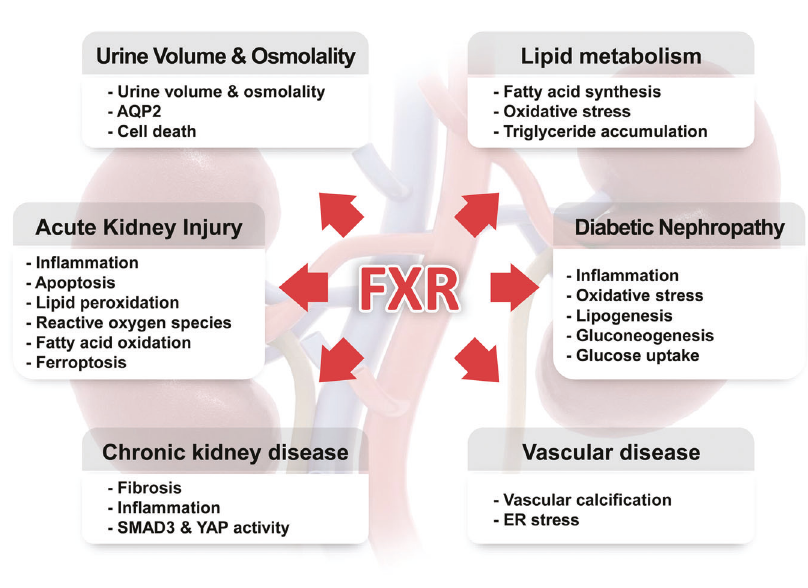
Fig. 1 Roles of FXR in the physiology and pathophysiology of the kidney. Schematic of the roles of FXR in kidney physiology and diseases. Activated FXR in the kidney regulates urine volume, osmolality, and lipid metabolism. It has protective effects against acute kidney injury, chronic kidney disease, diabetic nephropathy, and vascular diseases through anti-in fl ammatory, anti fi brotic, antilipogenic, and antioxidant effects. It also plays regulatory roles in glucose metabolism.